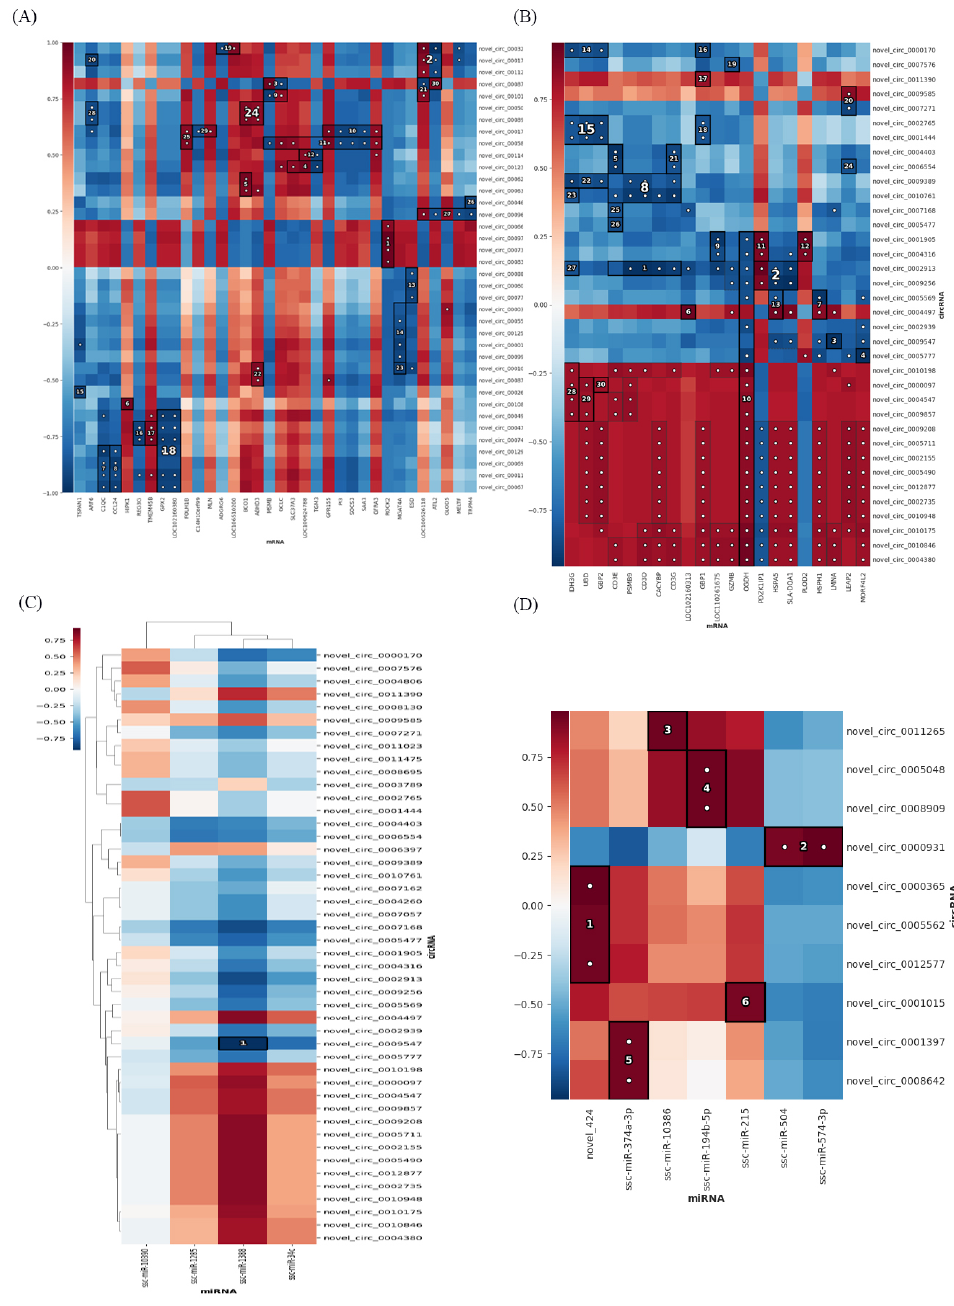
Figure 5. Association analysis of cicrRNAs − mRNAs and cicrRNAs − miRNAs. ( A ) Association results between cicrRNAs and mRNA in the P set. ( B ) Association results between cicrRNAs and mRNA in the I − V set. ( C ) Association results between cicrRNAs and miRNA in the I − V set. ( D ) Association results between cicrRNAs and miRNA in the P set. Color bars represent correlation coefficients: red for positive correlation and blue for negative